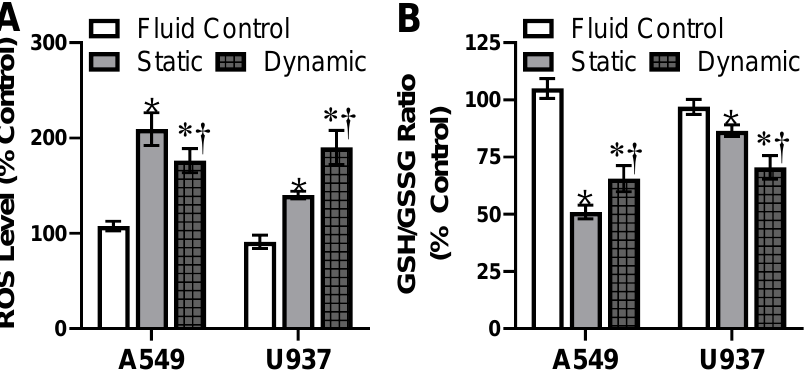
Figure 4. AgNP-induced intracellular oxidative stress levels. Both ( A ) ROS and ( B ) GSH/GSSG levels were used to monitor A549 and U937 intracellular oxidative stress following 5 µg/mL AgNP exposure for 24 h. Experimentation was carried out under both static and dynamic conditions. Dynamic flow without AgNP conditions were also included as fluid control. Oxidative stress levels were found to be a function of cell type and flow condition. * and † indicate statistical significance compared to the untreated control and between static and dynamic conditions, respectively. n = 3, p < 0.05.